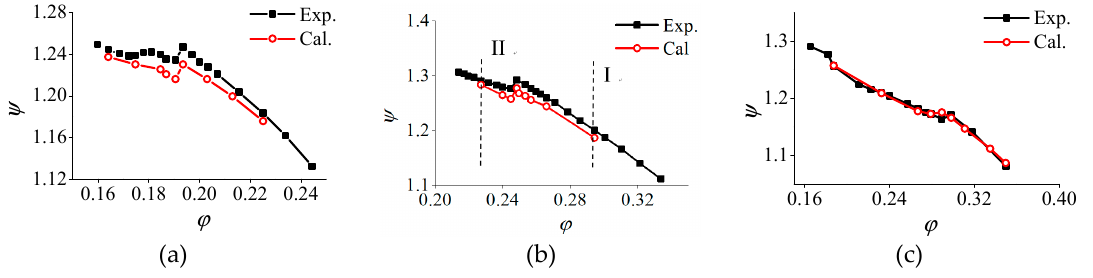
Figure 7. Pump performance curves at ( a ) α =45%, (b) α =75% and ( c ) α =145%.